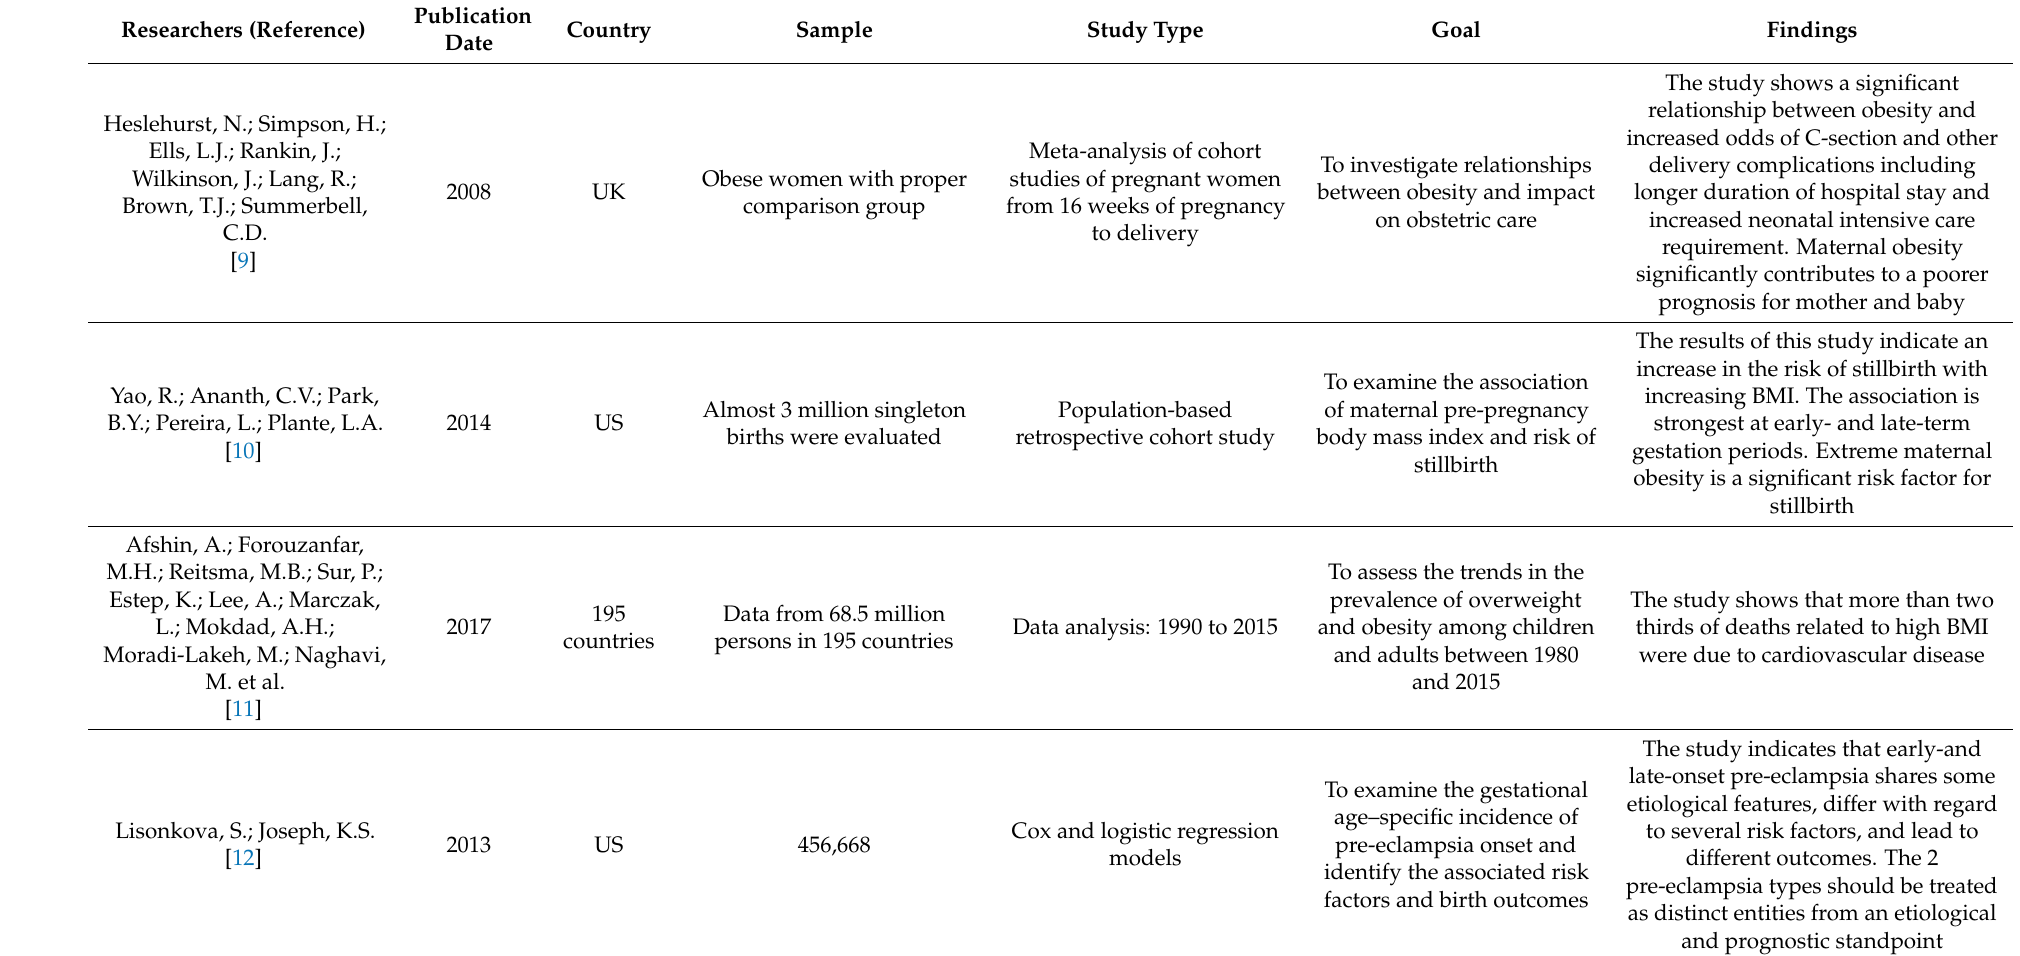
Table 1. The articles used for this review are ordered by the reference number by which the articles were introduced and discussed in the manuscript (see list of abbreviations at the end of the review for